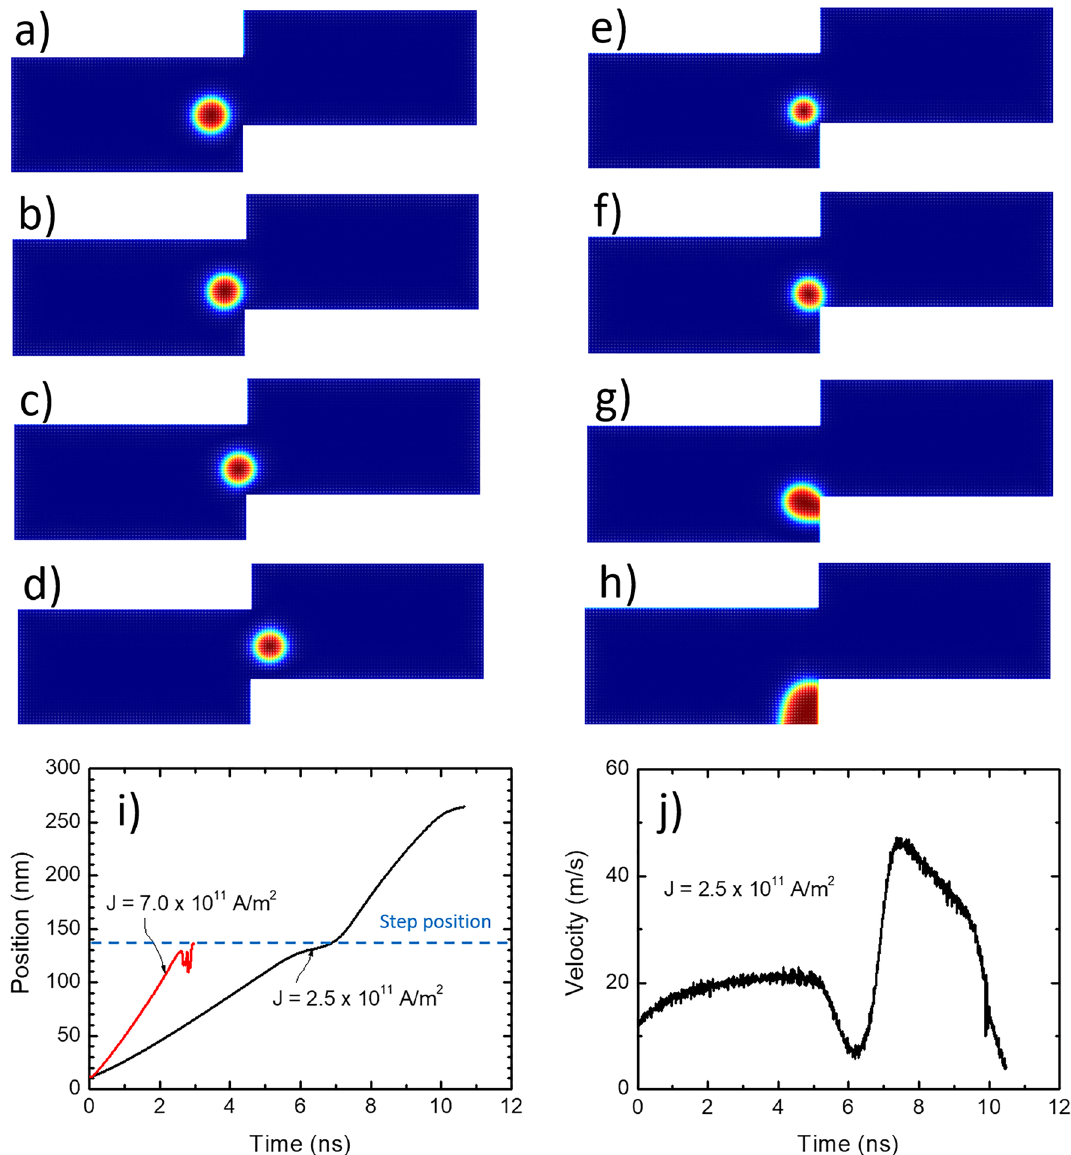
Figure 4. The motion of skyrmion within a stepped nanowire for ( a – d ) J = 2.5 × 10 11 A/m 2 where the skyrmion could overcome the stepped region and ( e – h ) J = 7.0 × 10 11 A/m 2 where it was annihilated. The snapshots ( a ) to ( d ) are taken for D = 3.55 mJ/m 2 at t = 2.61 ns, 2.79 ns, 3.06 ns and 3.24 ns, respectively while images taken for ( e – h ) are for t = 2.34 ns, 2.43 ns, 2.52 ns and 2.61 ns ( D = 3.30 mJ/m 2 ), respectively. ( i ) is a plot of the time dependence of the skyrmion position for J = 2.5 × 10 11 A/m 2 and 7.0 × 10 11 A/m 2 and ( j ) is the velocity for the skyrmion moving under J = 2.5 × 10 11 A/m 2